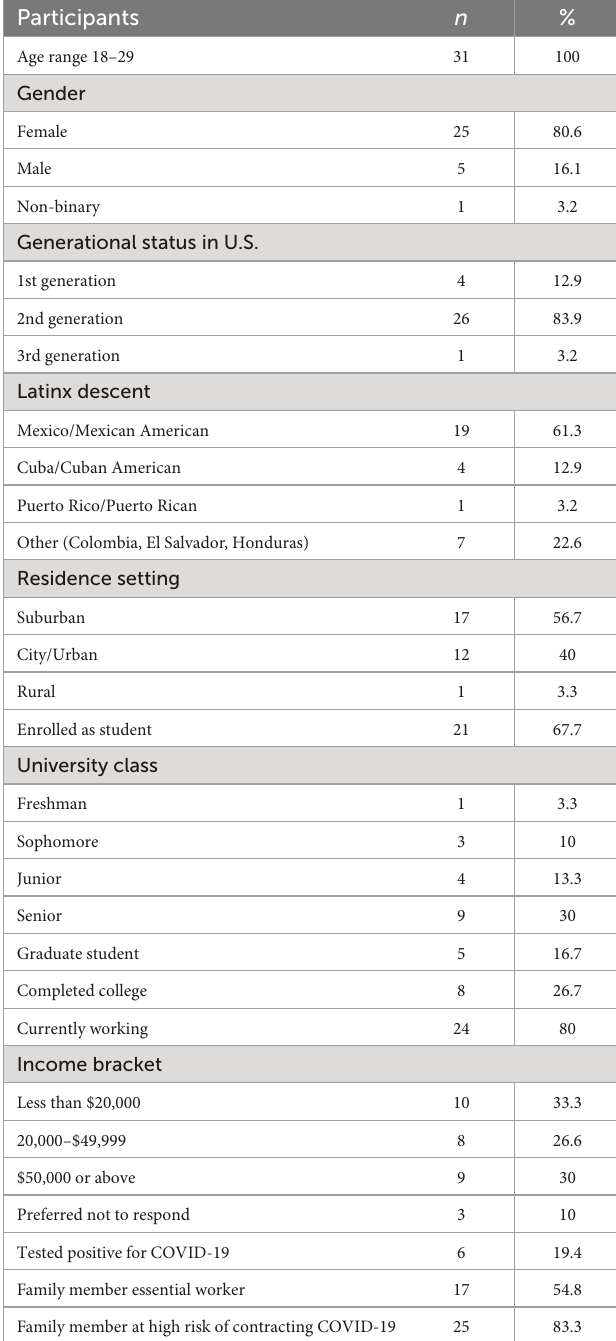
TABLE 1 Demographic characteristics of study participants ( N =